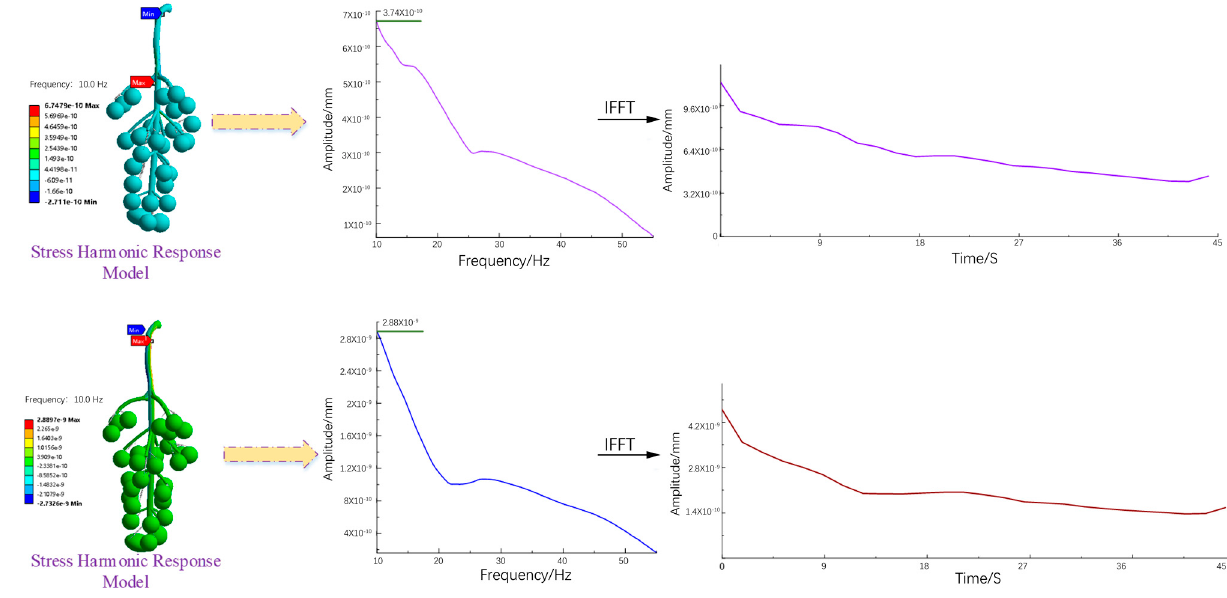
Figure 6. Stress curves in different directions.